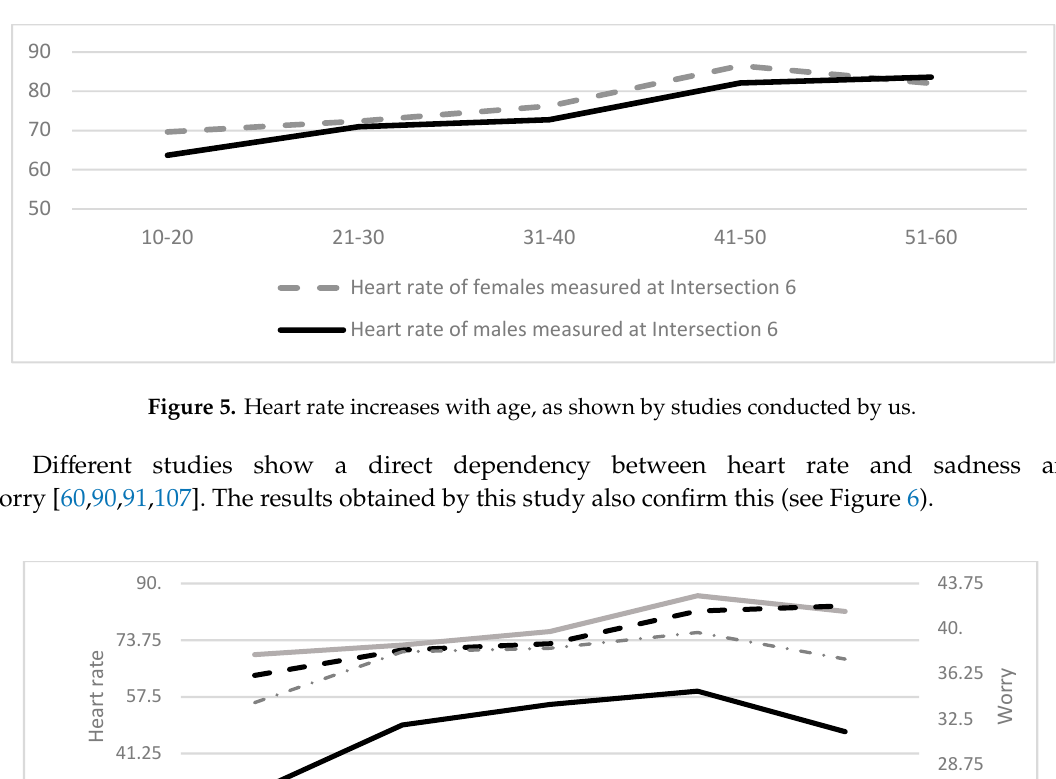
Heart rate of females measured at Intersection 6 Heart rate of males measured at Intersection 6 Figure 6. A direct dependency between heart rate and worry. Figure 6. A direct dependency between heart rate and